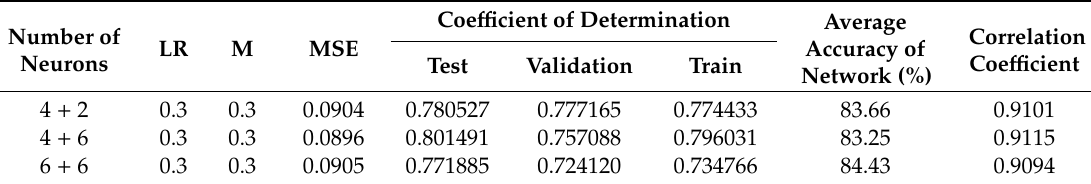
Table 1. Quantitative indicators for evaluating networks developed using the Levenberg–Marquardt